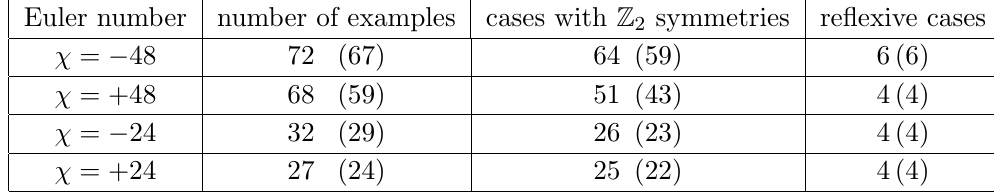
Table 1 . The number of Calabi-Yau 5-folds that we constructed as hypersurfaces in weighted projective spaces. The values in parenthesis give the number of Calabi-Yau manifolds with di(cid:11)erent Hodge